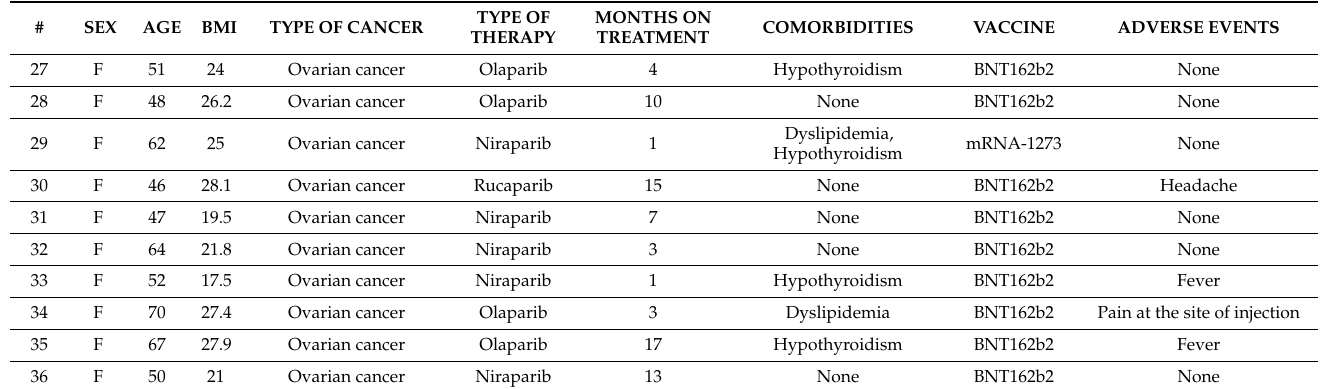
On day 1, there was no difference regarding the NAb titers between patients and controls ( p = 0.44). None of them had a prior history of known COVID-19. After the first vaccine dose, on day 22, patients had lower NAb titers compared to controls: the median